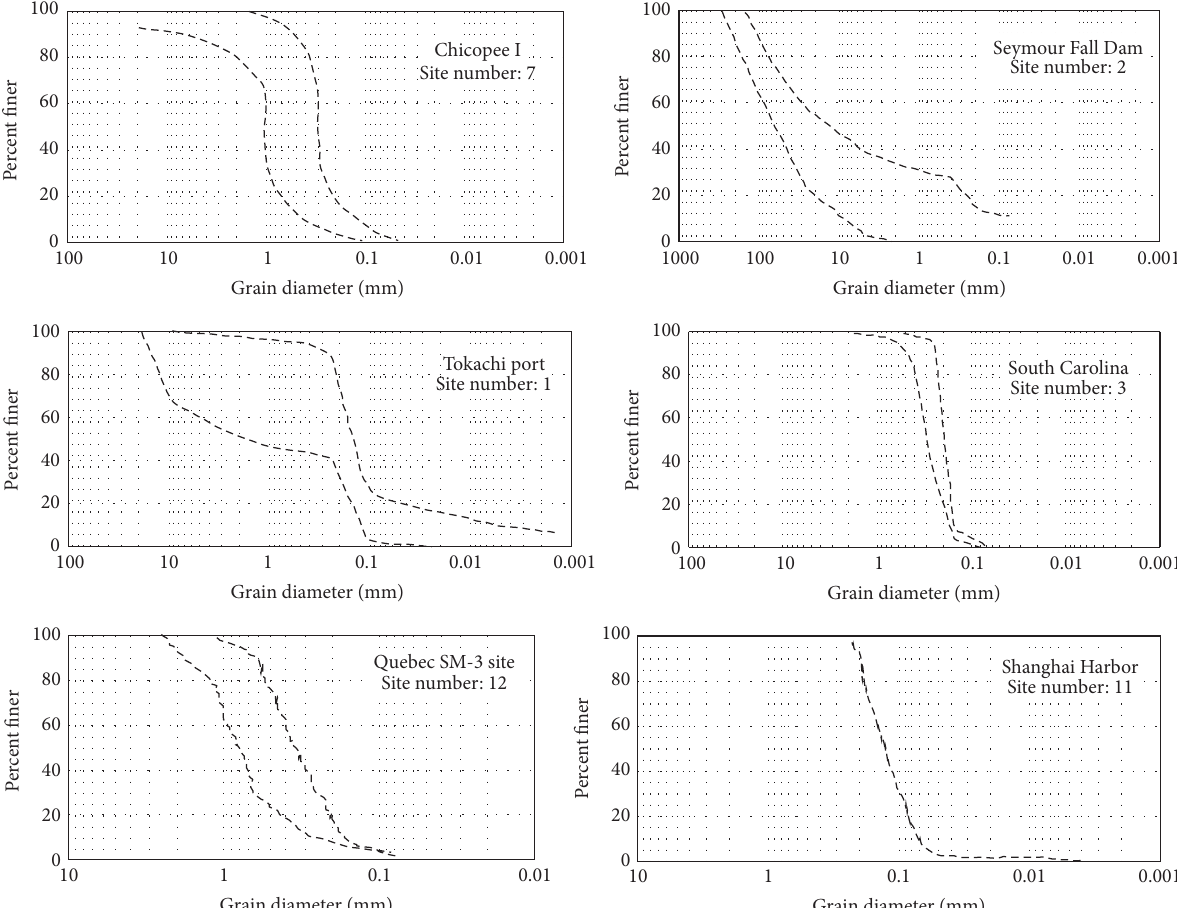
Figure 10: Grain size envelopes of target layer for some